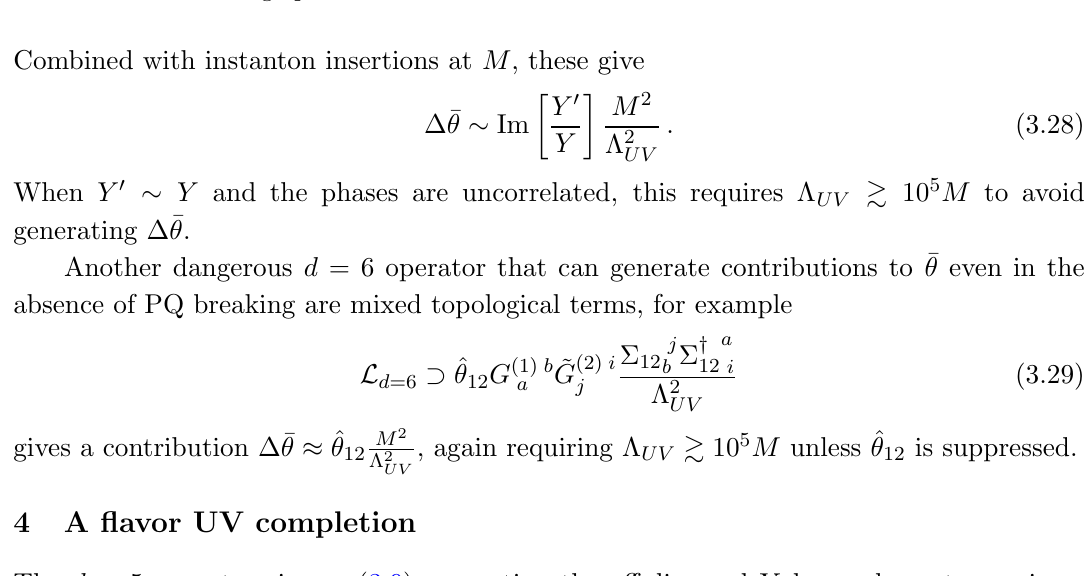
Table 3 . Vector-like quark content allowing a simple UV completion of the o(cid:11)-diagonal higher dimension CKM mixing